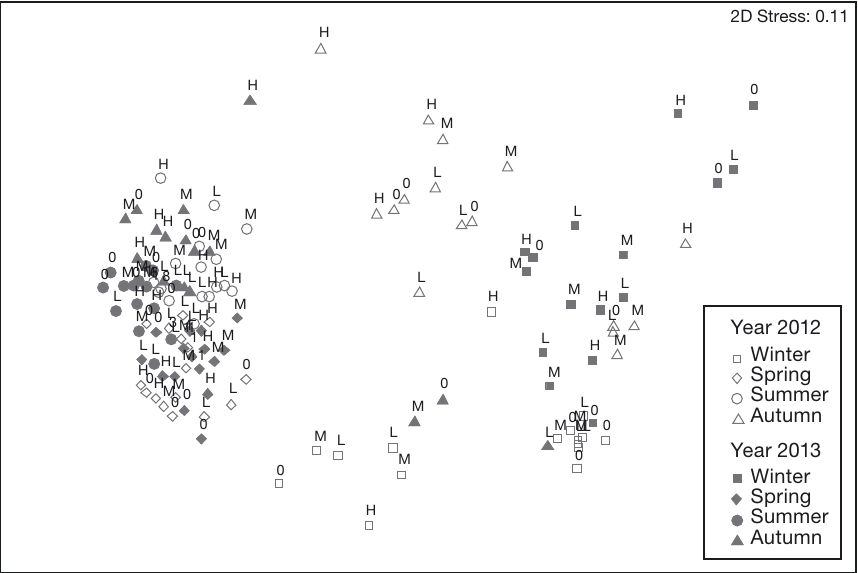
Fig. 3. Non-parametric multidimensional scaling (nMDS) plot for the wild fish assem- blage structure at different temporal scales. Letters over symbols indicate different feed- ing intensities (0: non-feeding; H: high feeding intensity; M: medium feeding intensity; L: low feeding